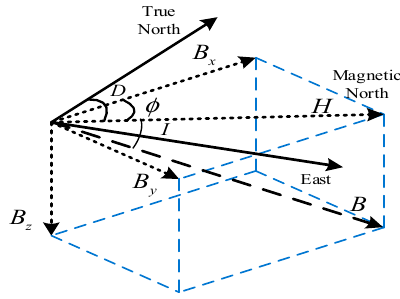
Figure 1. Magnetic field components and their relationship with true North.